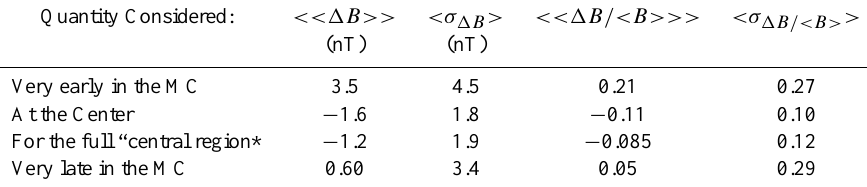
* Average and sigma derived over the interval of 10% to 90% of duration for β . + Average and sigma derived over the interval of 30% to 80% of duration for 1B and 1B / <B> . Table 2. Comparisons of <<1B>> and <<1B / <B>>> within the Average Magnetic Cloud for the 1T =242 Minute